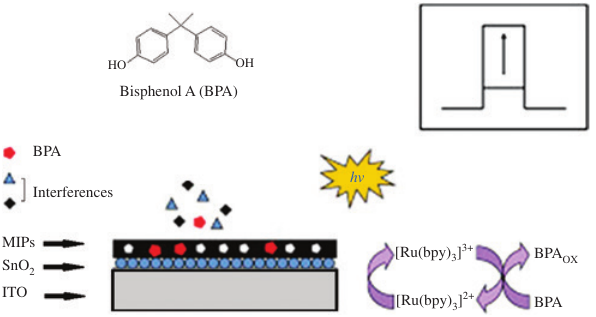
Figure 5: Schematic diagram of MIPs based on photoelectrochemi- cal sensor. This figure was reprinted from Zhang et al. (2015) with permission from